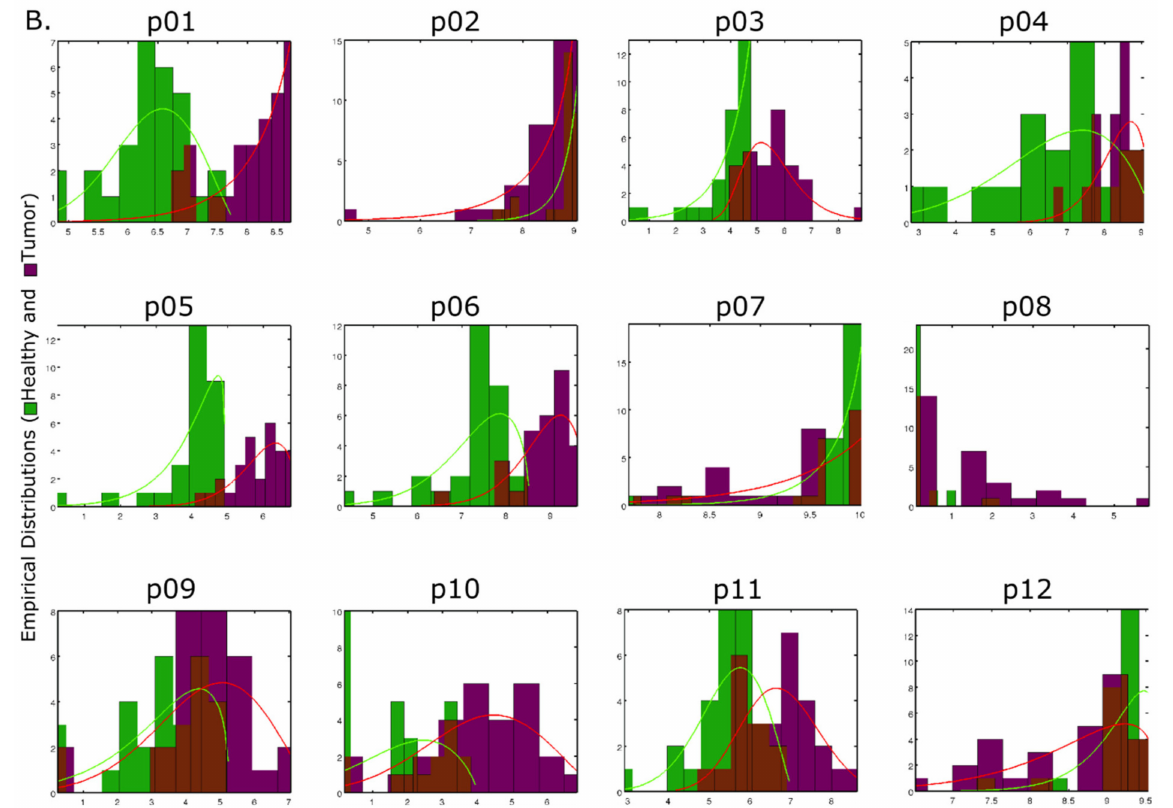
Figure 2. First step retrospective study: ( A ) Performance of the 12 generic probes (p) in differentiating between the healthy and tumor groups for the 29 paired samples (58 total). The plots represent the average and standard deviation of the normalized fluorescence intensity, showing the degradation of each individual probe. ( B ) Histograms and empirical distribution functions of the probes for healthy ( green ) and tumor ( red ) samples for the identification of the best performing probes. The empirical distribution functions are represented by the continuous lines in green and red for the healthy and tumor samples, respectively. Less overlap between distributions corresponds to better discrimination between the healthy and tumor